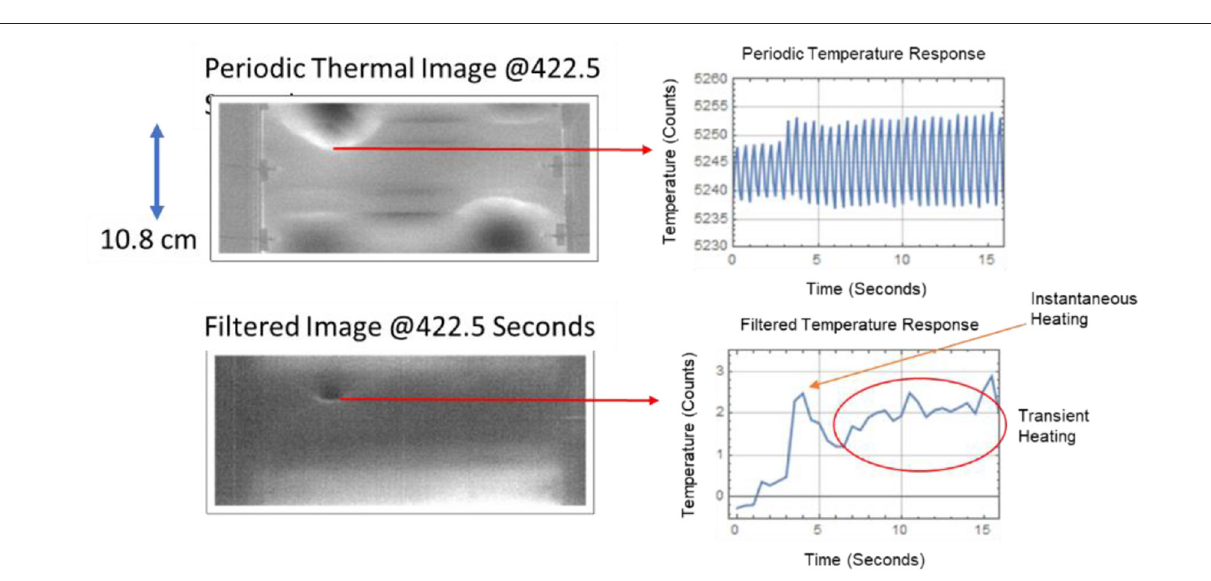
FIGURE 8 | Single stringer composite panel with periodic and filtered temperature